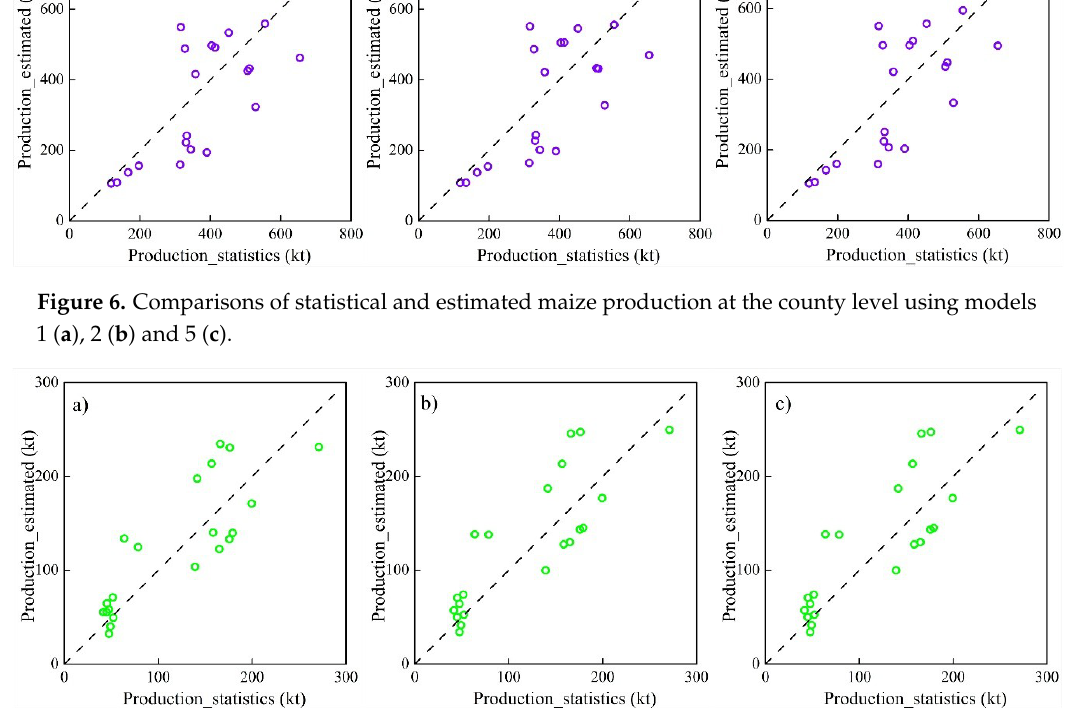
Figure 7. Comparisons of statistical and estimated sunflower production at the county level using models 5 ( a ), 6 ( b ) and 8 ( c ).